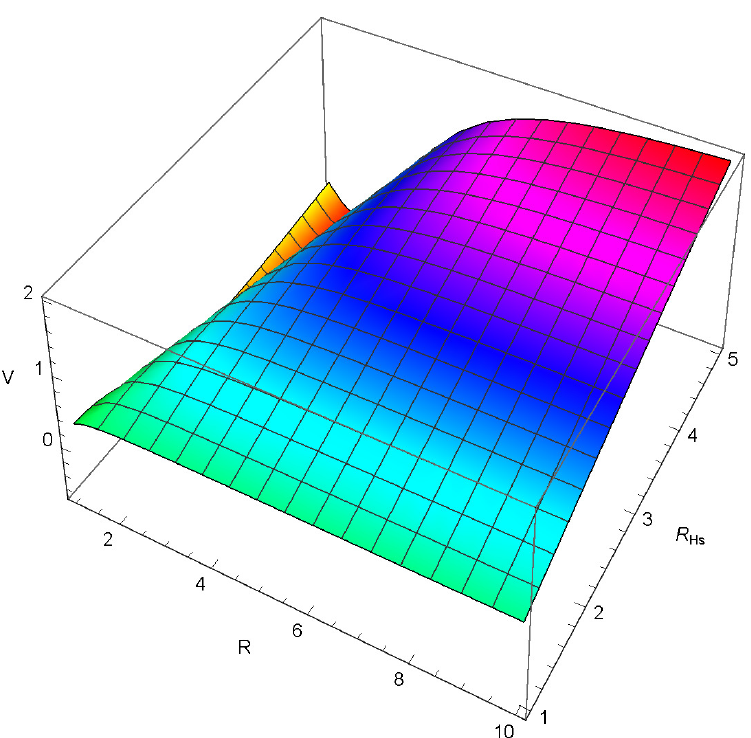
Figure 23. Solution of V ( φ 2 ) for p = 3. The evolution of V ( φ 2 ) is obtained using Equations (32) and